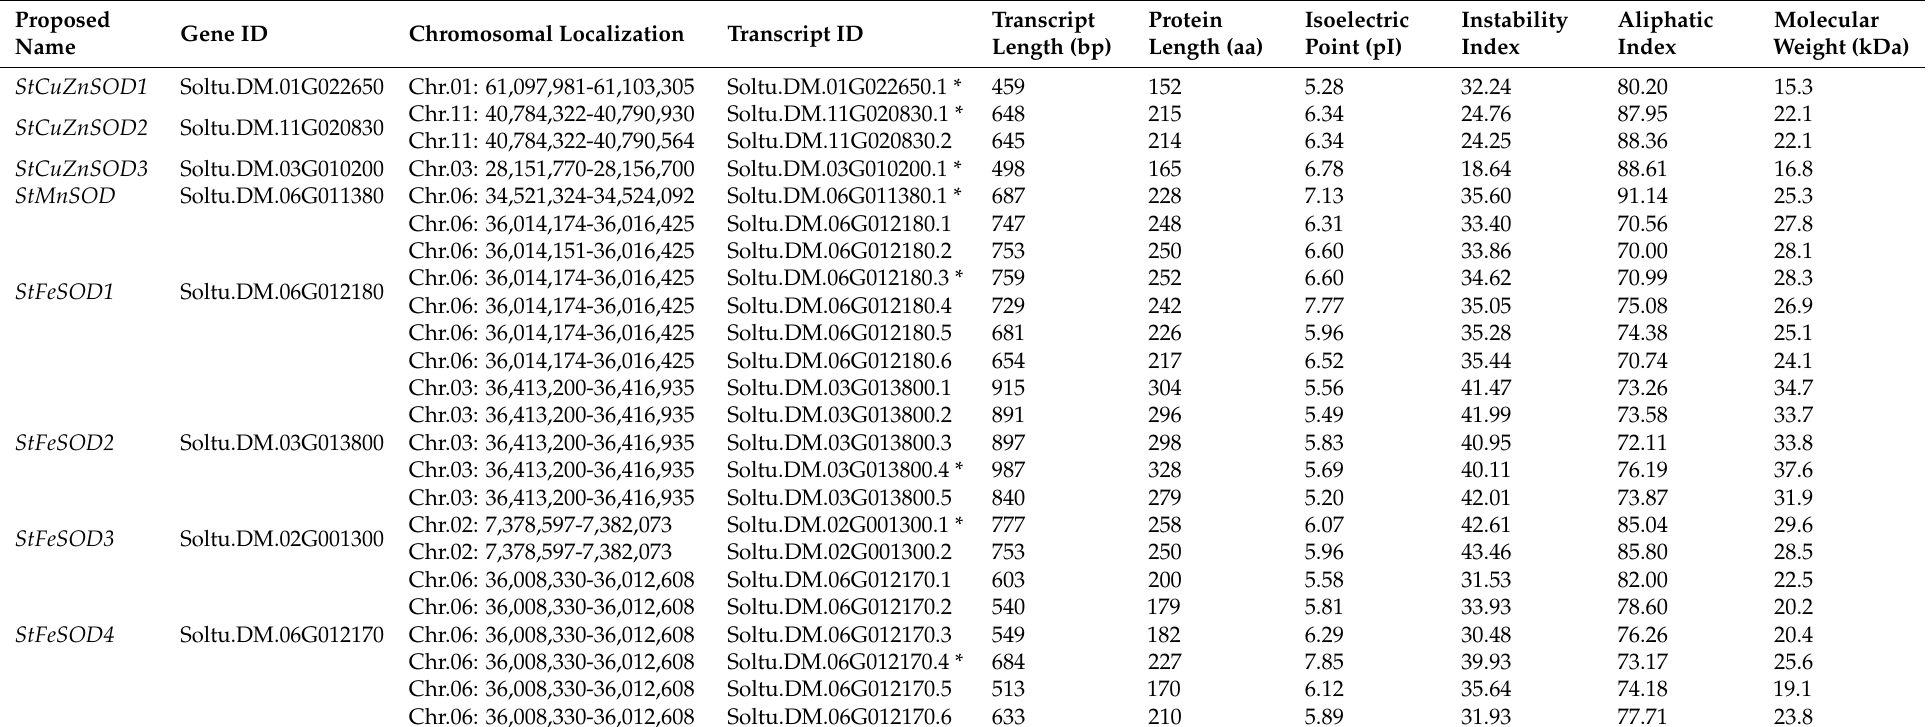
Table 1. Description of the potato SOD ( StSOD ) genes and proteins analyzed in this